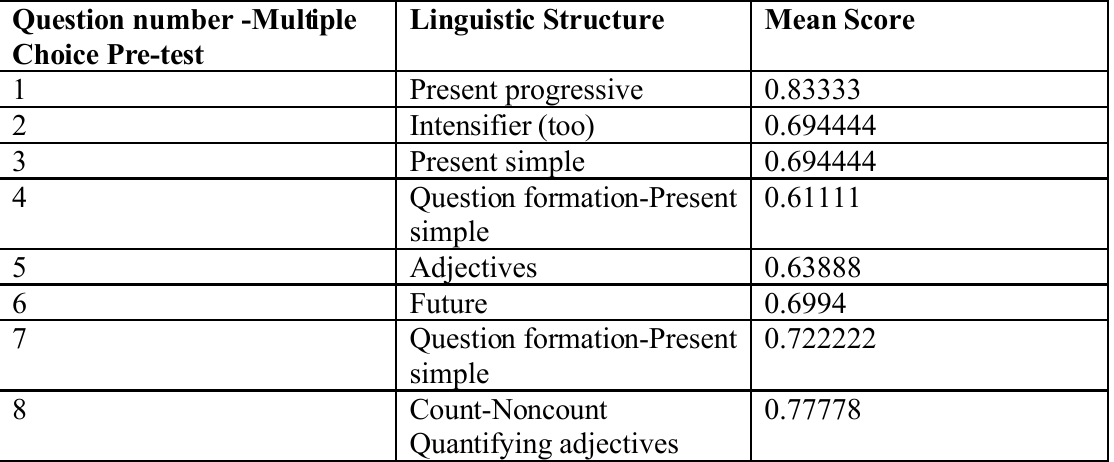
Pre-test Scores for Choice of Linguistic